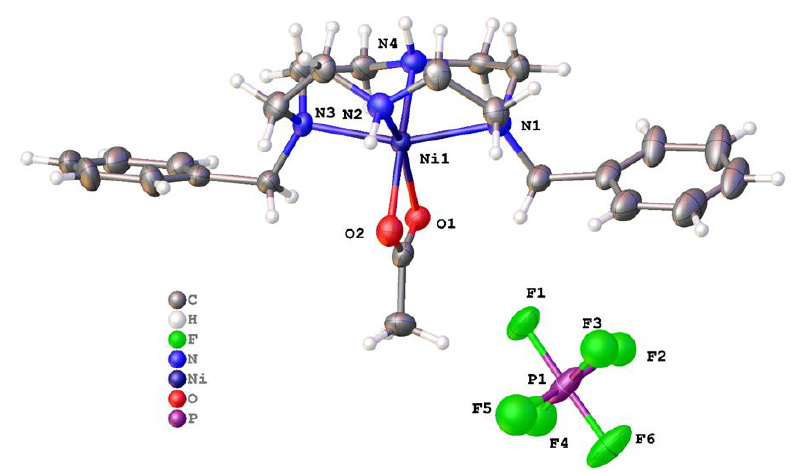
Figure 5. Molecular structure of [Ni( 1 )( µ -OOCCH 3 )]PF 6 . Atoms are drawn as 50% probability ellip- soids. For clarity, disorder is not represented.